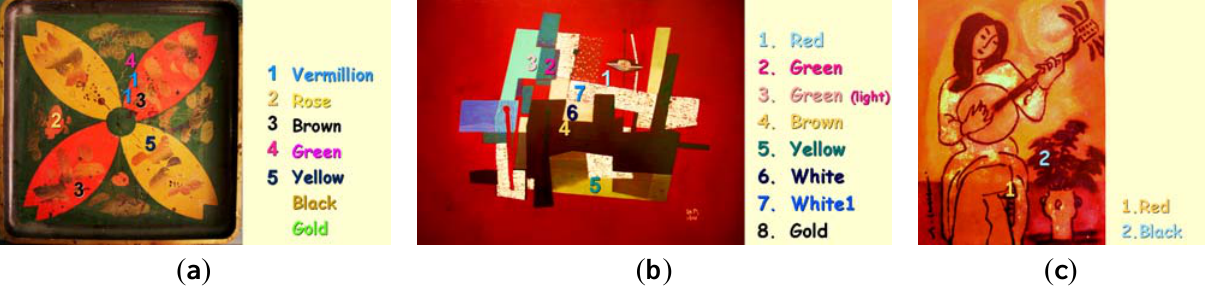
Figure 1. Reference lacquerwares: ( a ) Japanese tray, end of the 19 th century; ( b ) Vietnamese artwork from Ta Ty workshop, 1980s; ( c ) Vietnamese artwork, 1990s, depicting Kim heroin. The analysed spots are